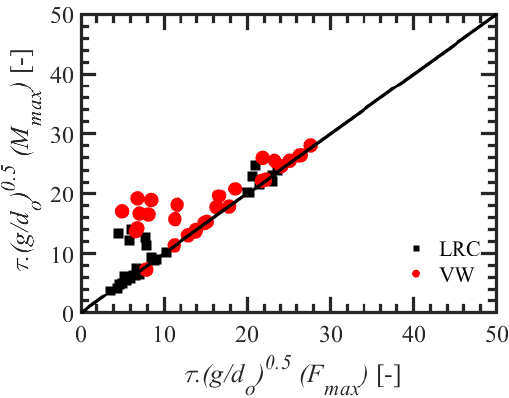
Figure 18. Comparison of time of maximum force and time of maximum moment in the presence of a mitigation wall. (Black squares represents the LRC, and red circles represents the VW). τ = ( t − t im ) .